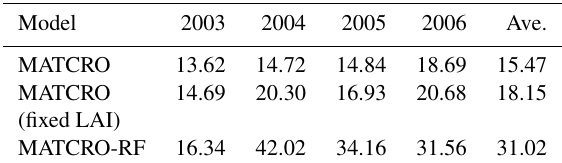
Table 7. RMSEs for daily